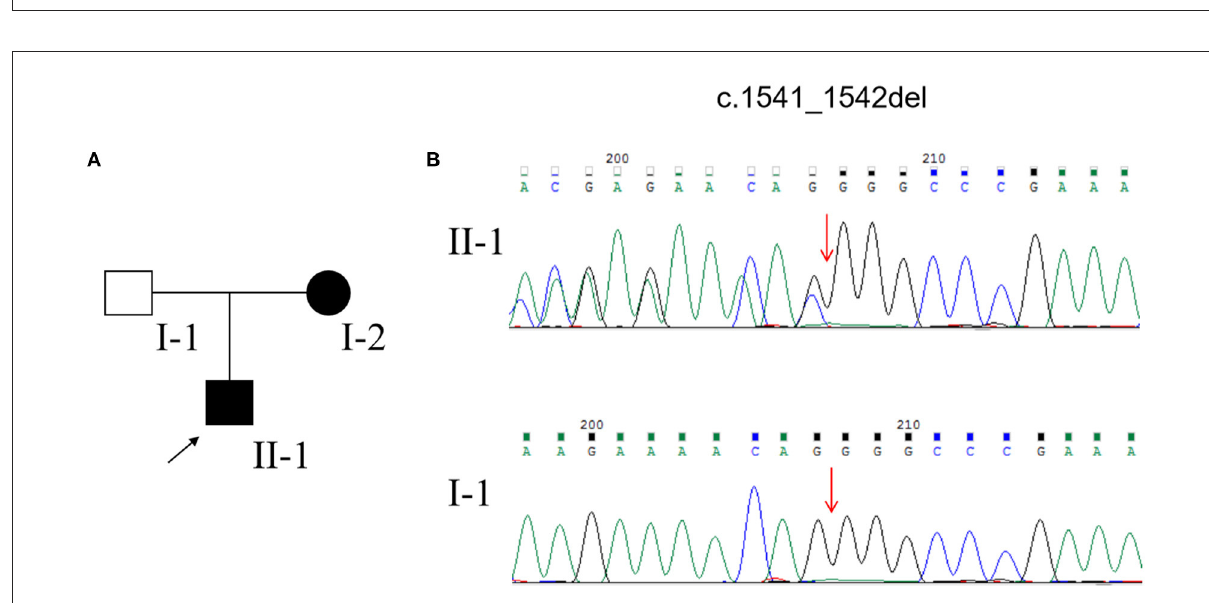
FIGURE3 (A) Pedigree of the family affected with NF1. (B) Sequencing results of the NF1